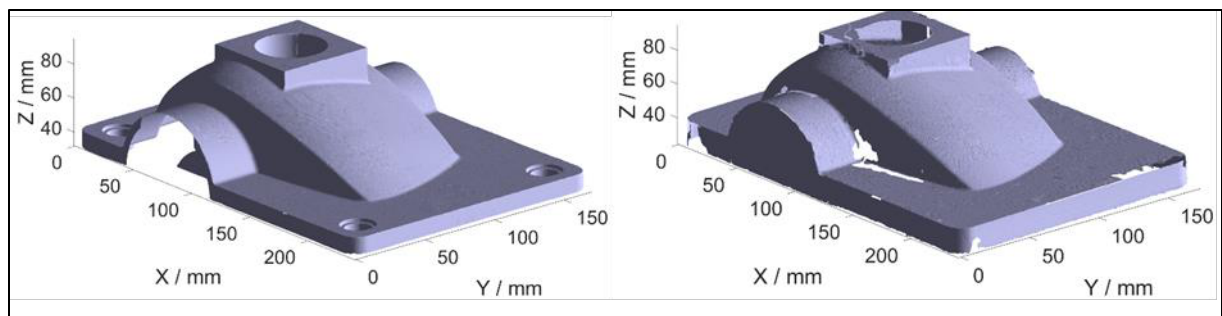
Figure 13. The generated point clouds for the evaluation of the features of the matte object with four different orientations.